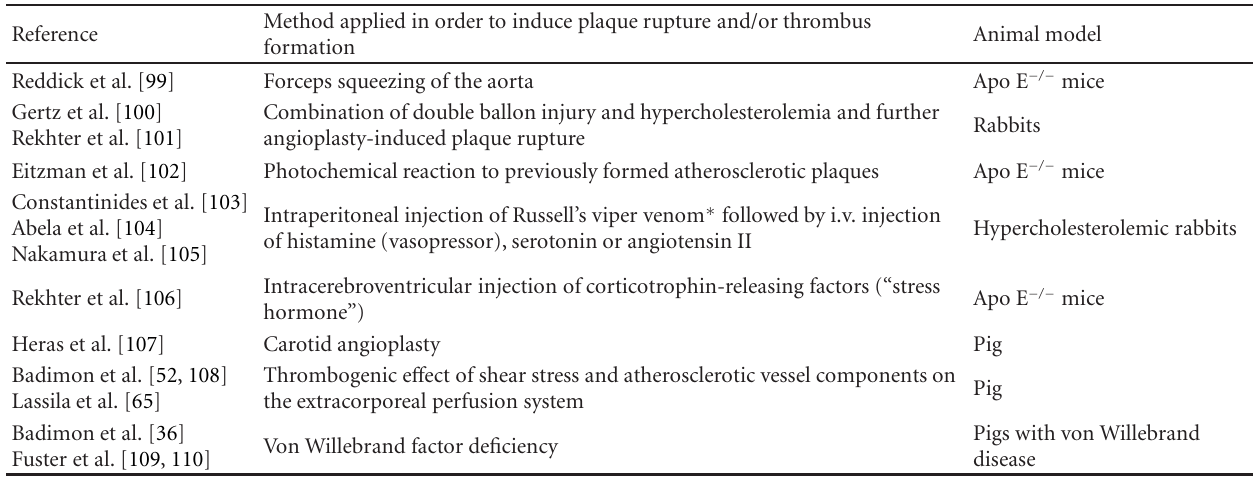
Table 2: Di ff erent animal models in order to evaluate thrombus